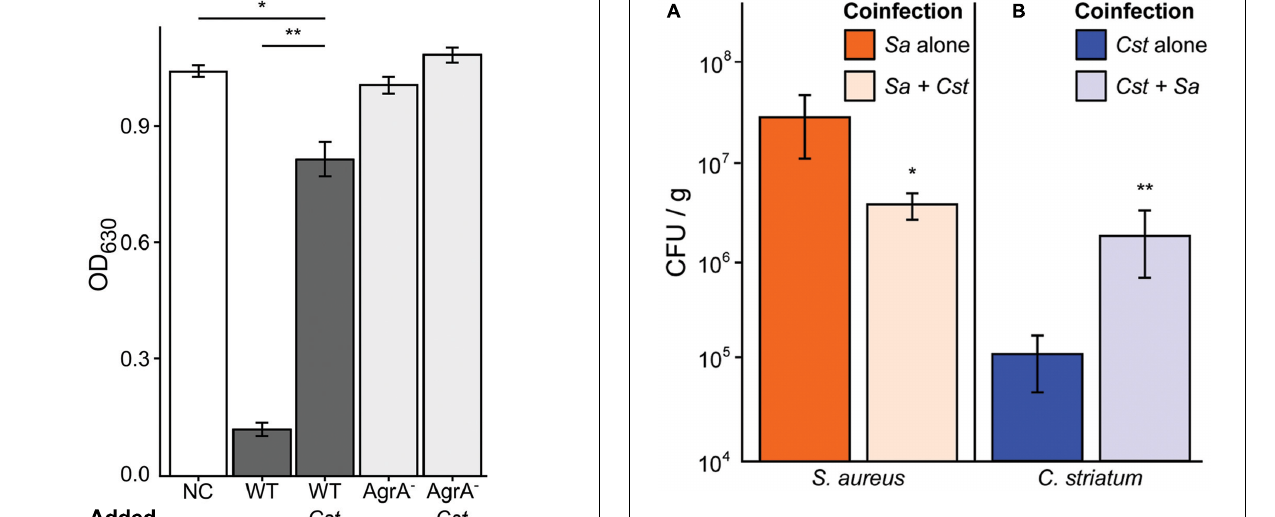
FIGURE 5 | Staphylococcus aureus abundance decreases in vivo when coinfected with C. striatum in a murine abscess model. (A) In a murine abscess infection model 4 days post-infection, wild-type S. aureus showed reduced numbers (CFU/g) during coinfection with C. striatum (light orange bar; Sa + Cst ) compared to monoinfection (orange bar; Sa alone). (B) In the same model, C. striatum numbers increased significantly when coinfected with S . aureus (light blue bar; Cst + Sa ) when compared to monoinfection (blue bar; Cst alone). For each bar, n = 9. Data were analyzed using the Mann Whitney U -test ( ∗ p < 0.03, ∗∗ p < 0.02). Error bars represent